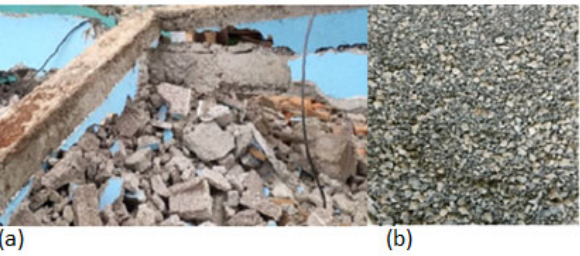
Figure 2. Recycled aggregate process: ( a ) demolished concrete waste; ( b ) recycled aggregate. Table 2. Summary of the properties of aggregates.